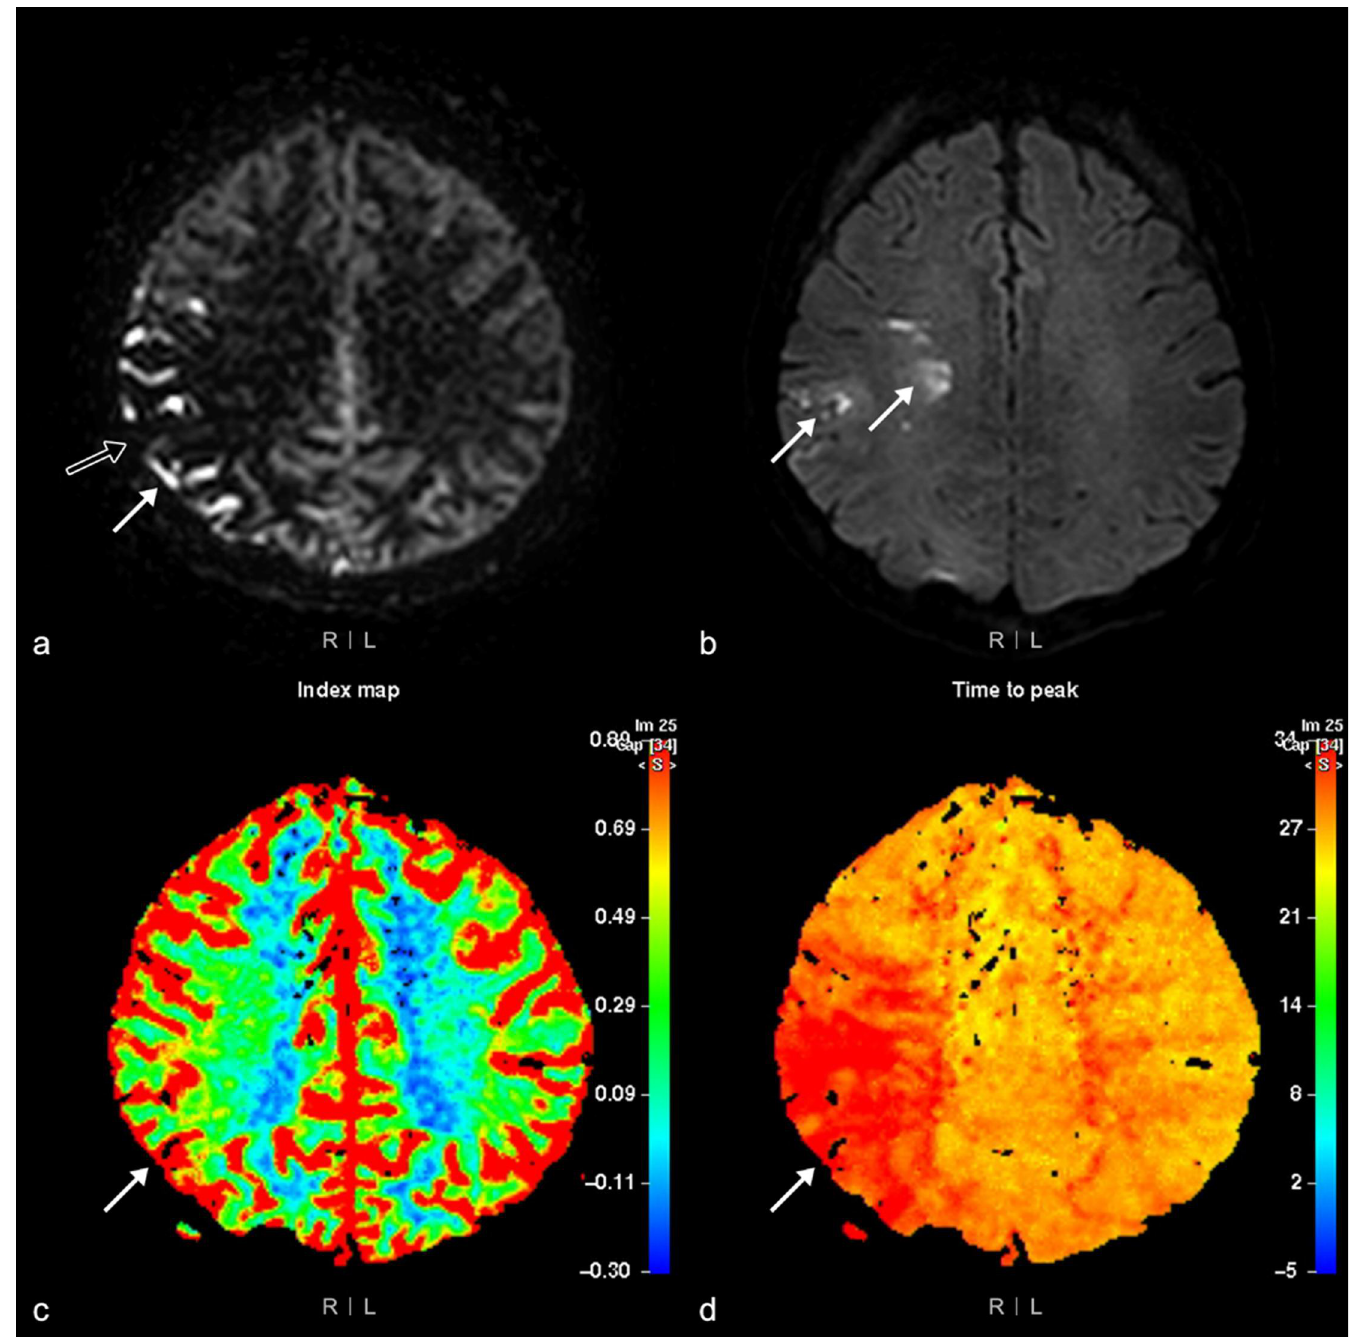
Fig 3. Arterial spin labeling (ASL) rank III perfusion abnormality. MRI of the brain of a 48-year-old woman with left-side motor weakness. The ASL image (a) shows a rank III perfusion abnormality, as hyperintense vessel signals (arrow) and parenchymal perfusion deficits (open arrow) are present in the right parietal area. However, high signal intensity (arrow) visualized by diffusion-weighted imaging (b = 1,000) (b) is detected only in the right frontal white matter and parietal area. Cerebral blood flow (c) and time to peak maps (d) show a mismatched perfusion defect (arrow) in the right parietal area.